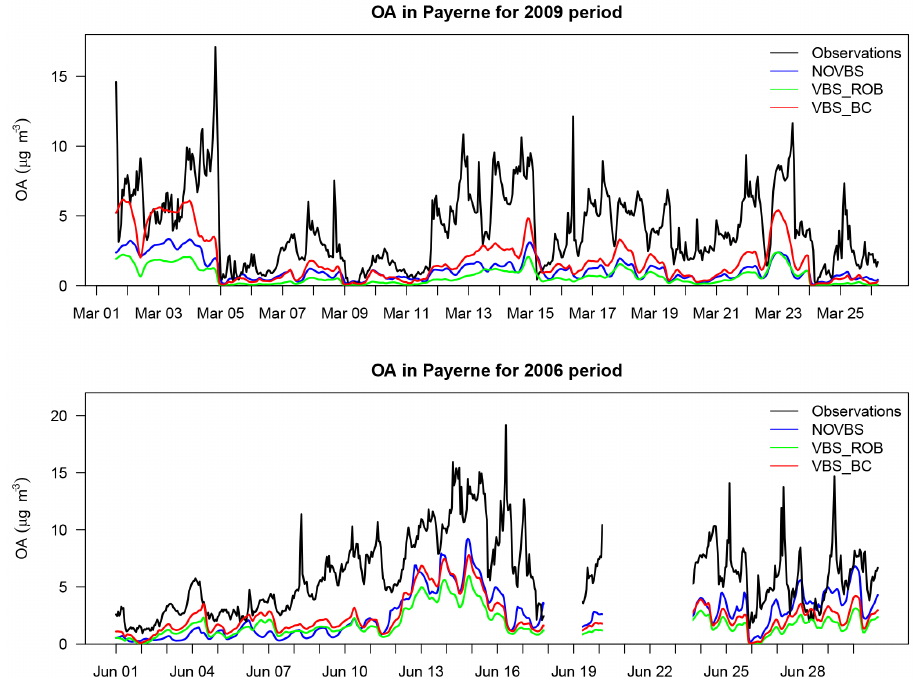
Figure 7. Predicted and observed total OA for scenarios NOVBS, VBS_ROB and VBS_BC in March 2009 (upper panel) and June 2006 (lower panel) at